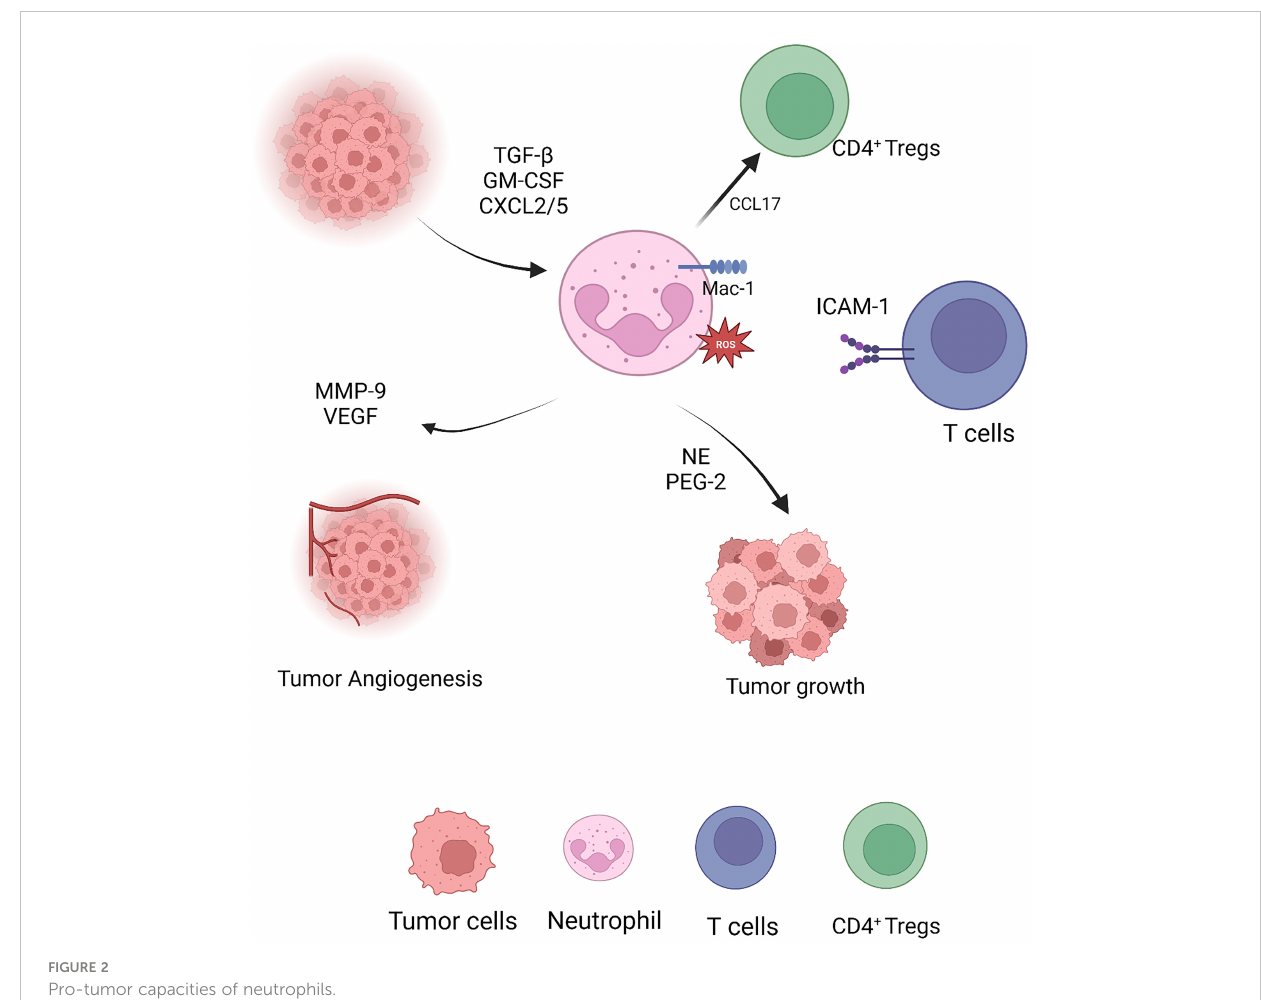
FIGURE 2 Pro-tumor capacities of